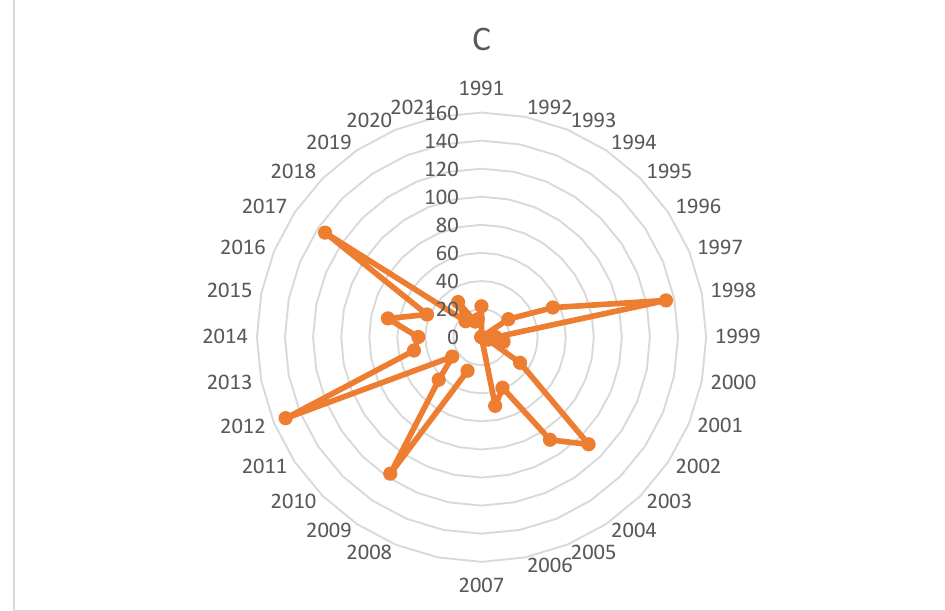
Figure 3. Number of citations per year (WoS).